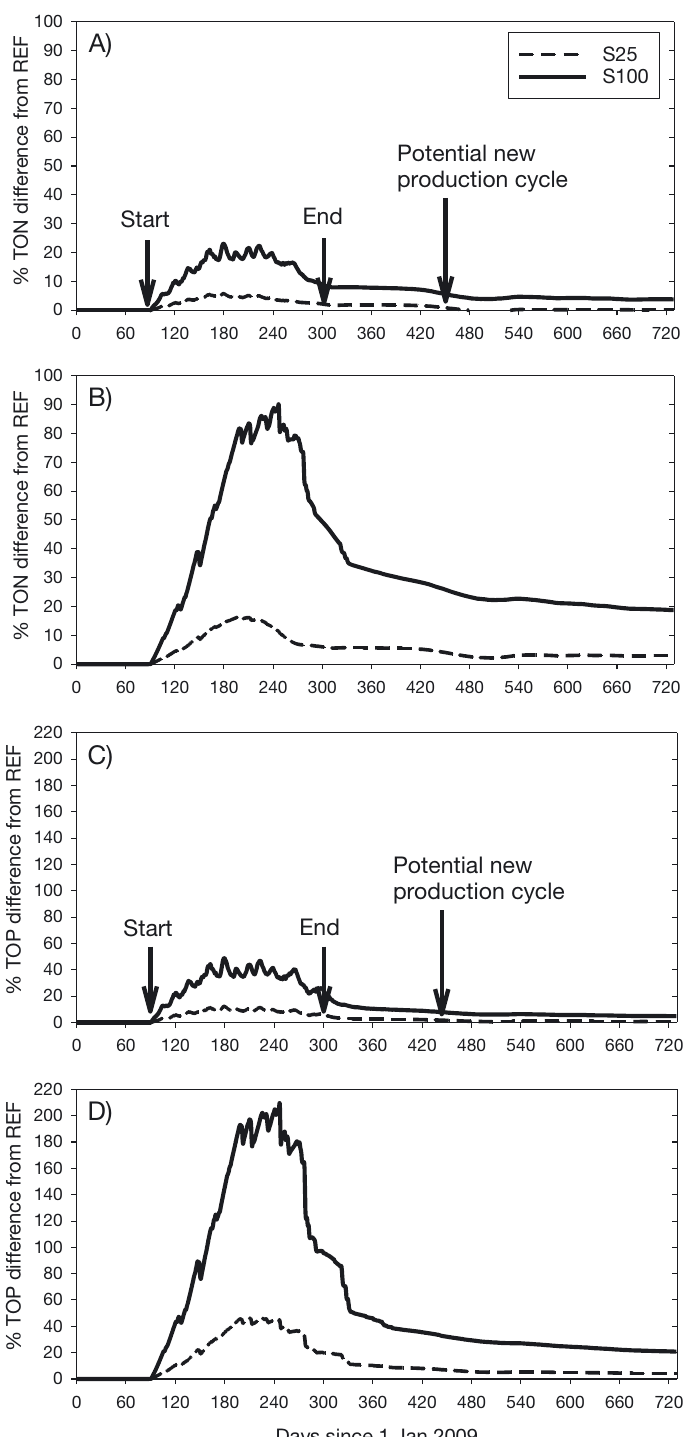
Fig. 9. Average difference below the fish cages in sediment total organic nitrogen (TON) at (A) Ballen and (B) Bolsaksen and total organic phosphorus (TOP) at (C) Ballen and (D) Bolsaksen between the reference run (REF) and each of the scenarios (S25, S100). Arrows indicate the start, end and potential new start the following year of the fish